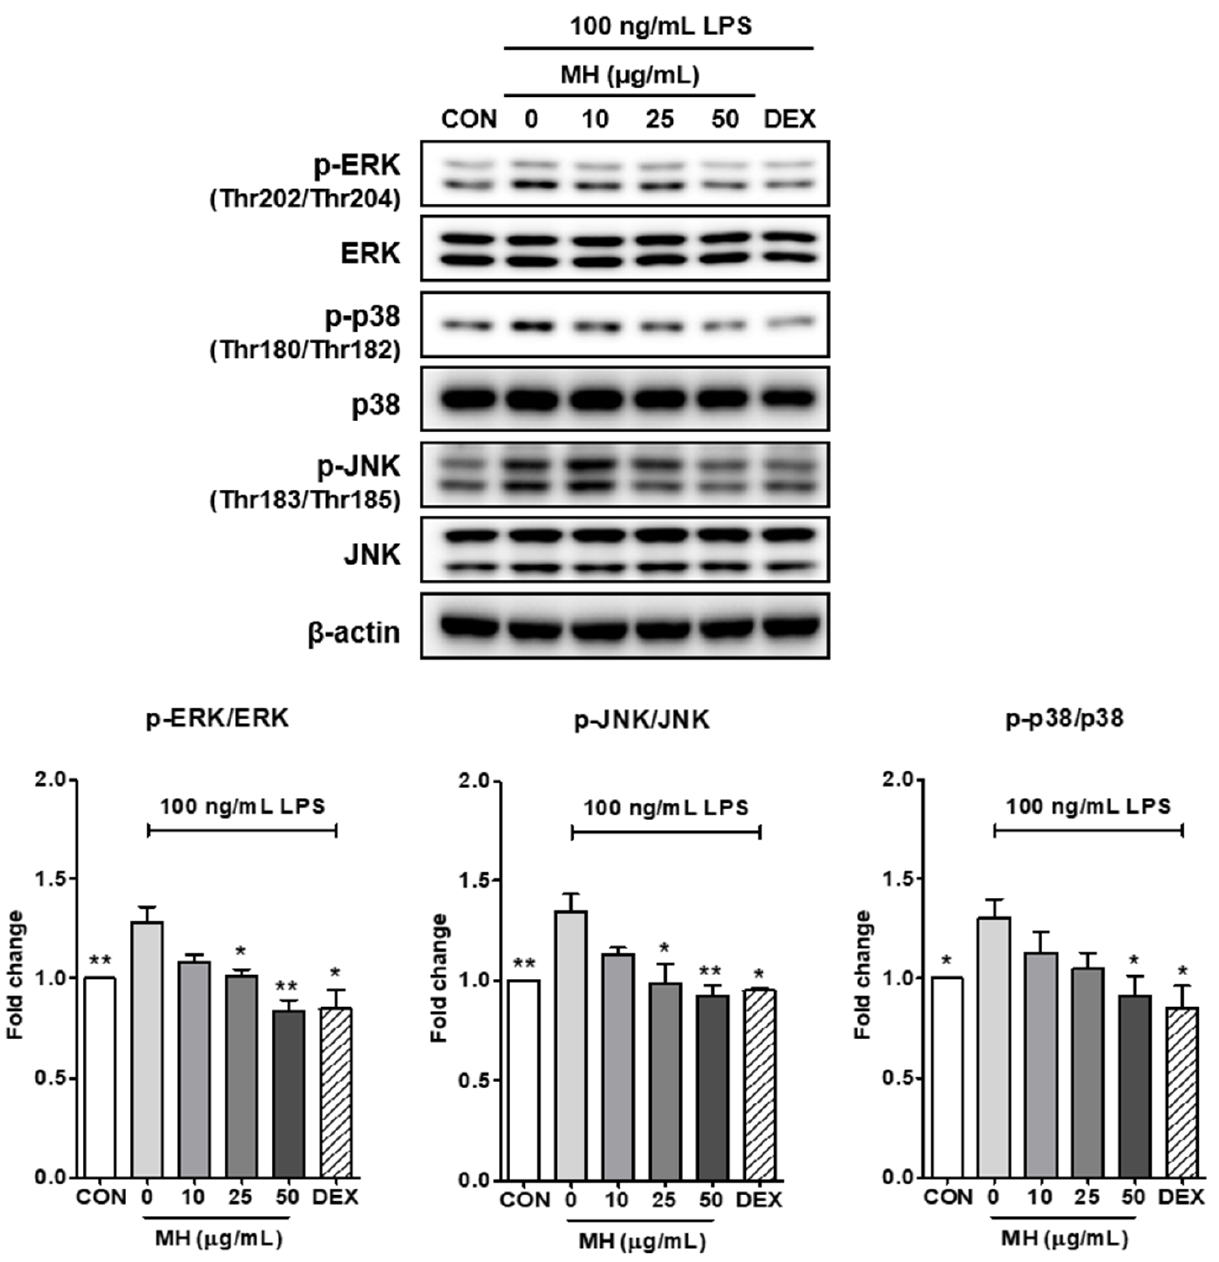
Figure 5. Effects of MH on the phosphorylation of ERK, p38, and JNK MAPK. Representative Western blots and densitometric quantification of p-ERK, ERK, p-p38, p38, p-JNK, and JNK expression in BV2 cells treated with LPS (100 ng/mL) alone or in combination with 3 doses of MH or left untreated (CON). The cells were preincubated with the indicated concentration of MH or 10 µ M DEX for 1 h before stimulation with LPS. The cells were stimulated with LPS for 30 min. β -actin was used as an endogenous control. Data are expressed as the mean ± SEM. * p < 0.05 and ** p < 0.01 vs. LPS